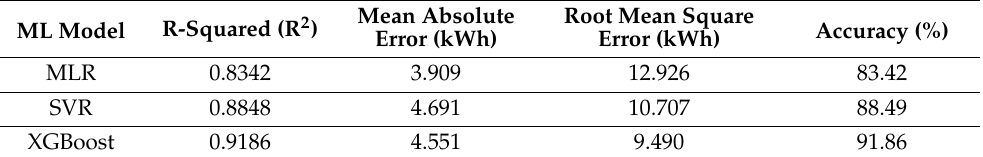
Table 3. Comparison of the performances of different ML models in prediction of EVs TEC.